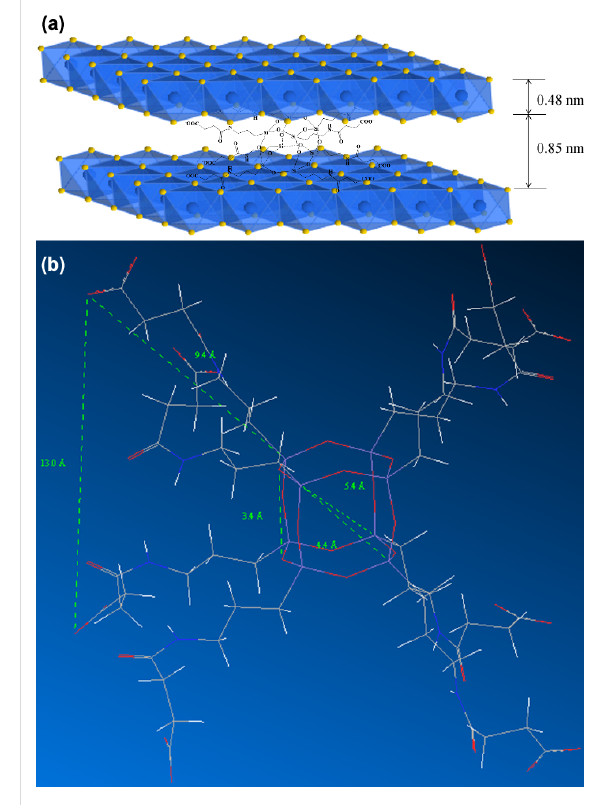
Figure 7: (a) Possible crystallographic structure of OLDH; (b) Energy- minimized molecule structure of an OCPS anion (geometrically opti- mized by chem3D and